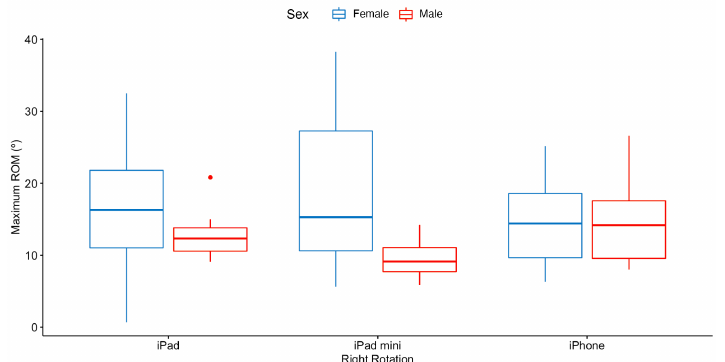
Figure 8. Maximum ROM achieved (in degrees) by sex for the right rotation movement for each